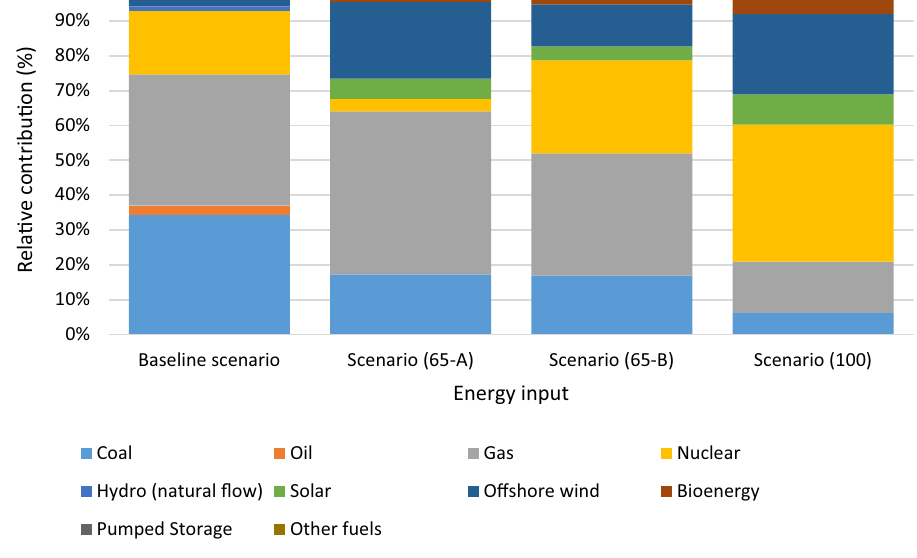
Fig. 2 Electricity-input sce- narios considered in this study, adapted from Stamford and Azapagic (2014). The figure above shows the average con- tribution of each energy source to each scenario from 2014 to 2070